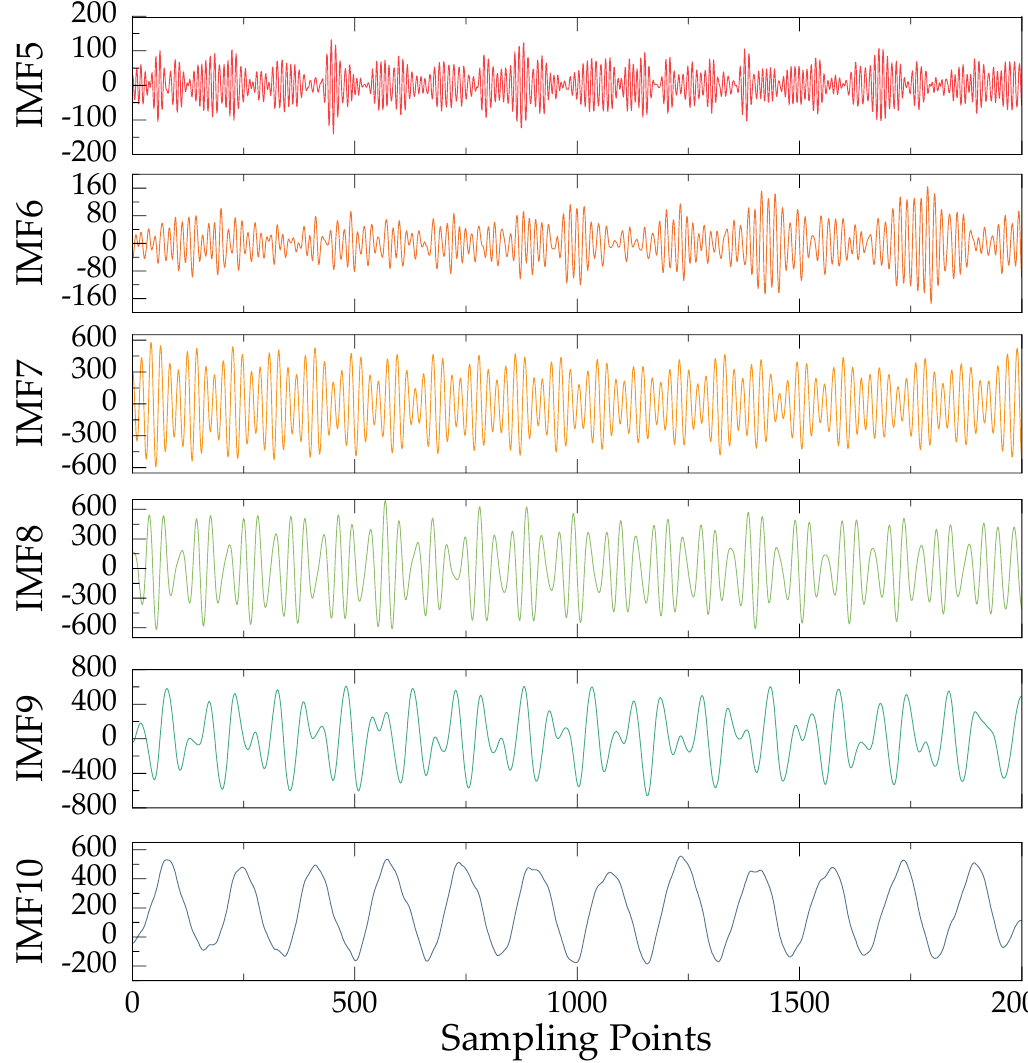
Figure 7. Post-sixth order intrinsic mode function components of the VMD decomposition results of the reconstructed signal.